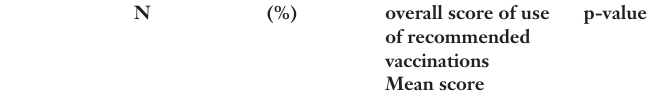
Table 4 Relations between potential barriers to vaccination and over- all score of use of recommended adult vaccinations among 1166 non-paediatric Swiss primary care